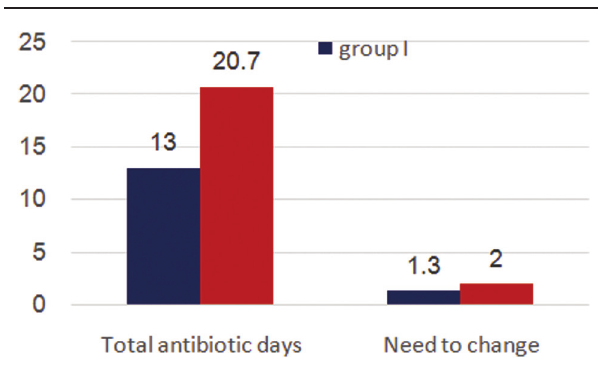
Comparison between group regarding bacteriological outcome on day 5 of aerosolized antibiotics